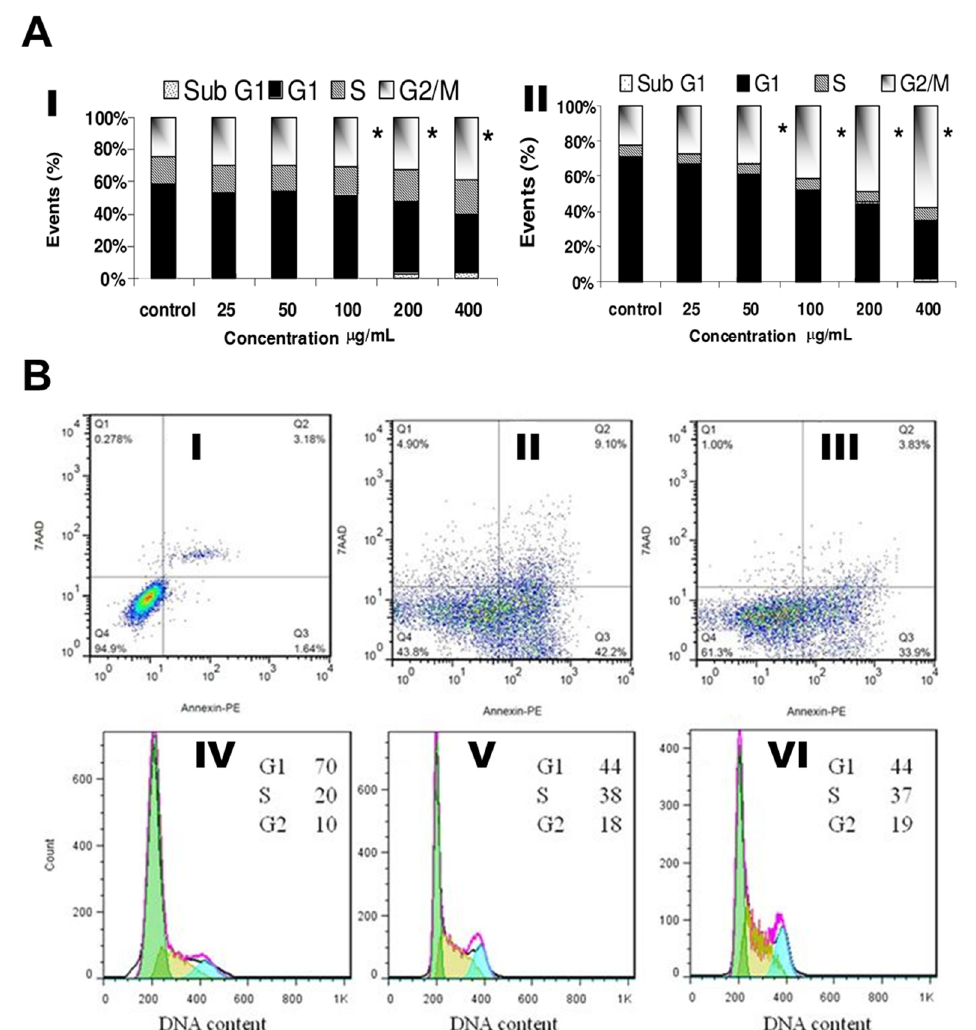
Figure 4. The condition of AgNP-treated cell cycles in U251 cells: (A-I) the gradual increase of the S/G2 stage. (A-II) the G2/M arrest in IMR-90 cells which may happens in a concentration ( μ g/mL)-dependent manner. All panels reprinted with permission from Reference [74], Copyright 2008 American Chemical Society. 2D density plots of panels (B-I , II and III) provide a fraction of early apoptotic, late apoptotic, and necrotic cell murder of MDA-MB-231 cells, respectively. Panel (B-I) exposures of the natural cells as controls, while panels (B-II and B-III) exhibit the cells with an LD 50 of AgNPs and albumin-coated-AgNPs exposures, respectively. Necrosis and apoptosis were assessed with the use of 7-AAD and Annexin-V dyes in flow cytometry methods. Panels (B-IV , V , and VI) demonstrate the impact of albumin-coated-AgNPs exposures on the cell cycles. (B-IV) Untreated cells and (B-V and B-VI) tumor cells with AgNPs and albumin-coated-AgNPs exposures, respectively. The cells’ DNA content was plotted with help of flow cytometry. Adapted from Reference [79], Copyright 2017 Nature.